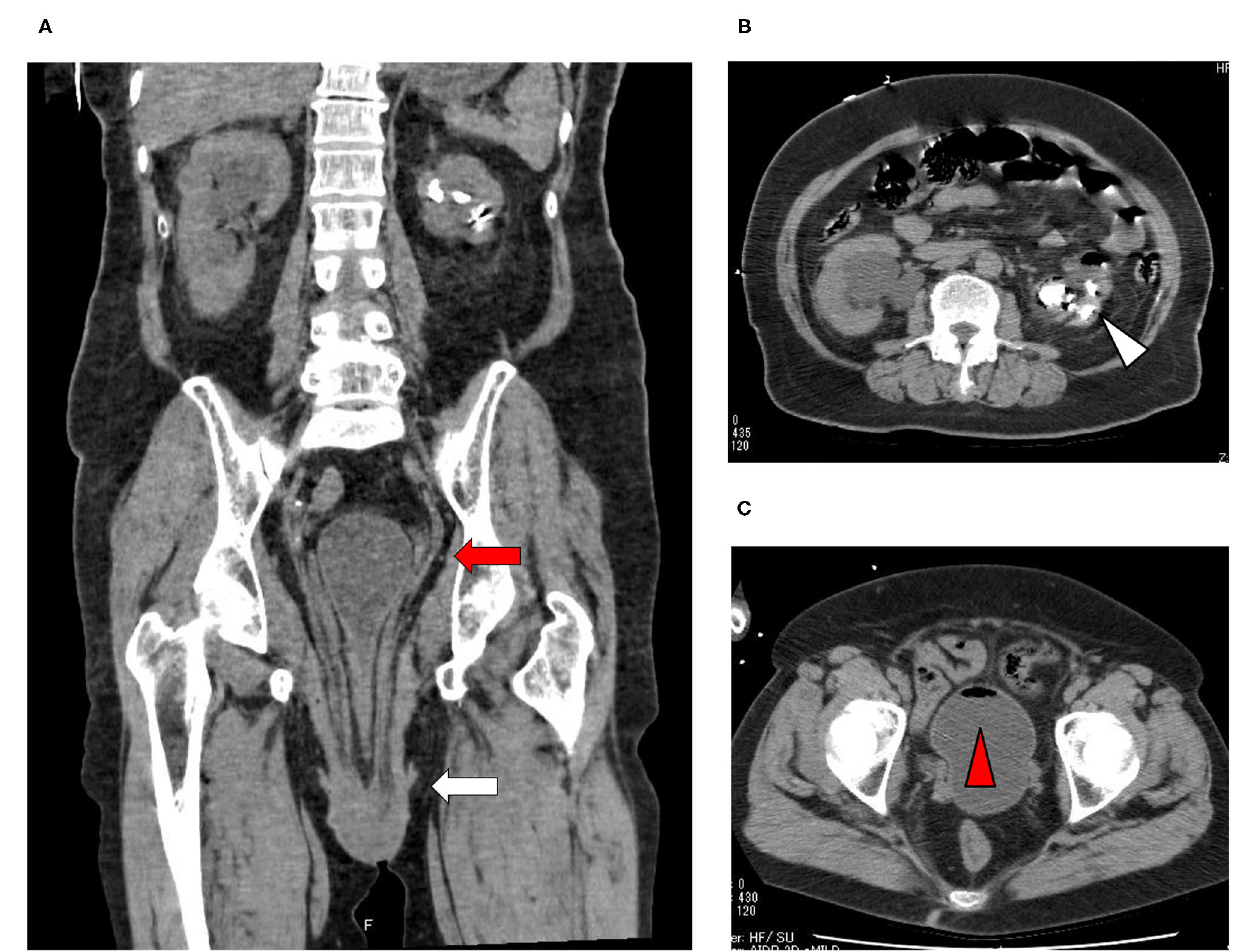
FIGURE 1 | (A) Abdominal CT revealed renal calculus and hydronephrosis, and pelvic CT revealed lower shift of bladder (red arrow) and severe uterine prolapse (white arrow). (B,C) Abdominal CT showed emphysematous pyelonephritis (white triangle), and pelvic CT showed emphysematous cystitis (red